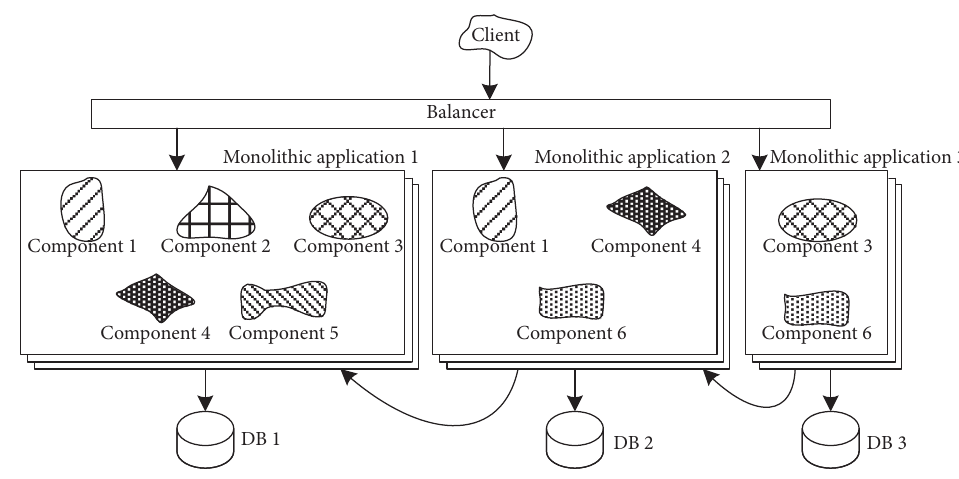
Figure 2: Framework of vertical architecture.